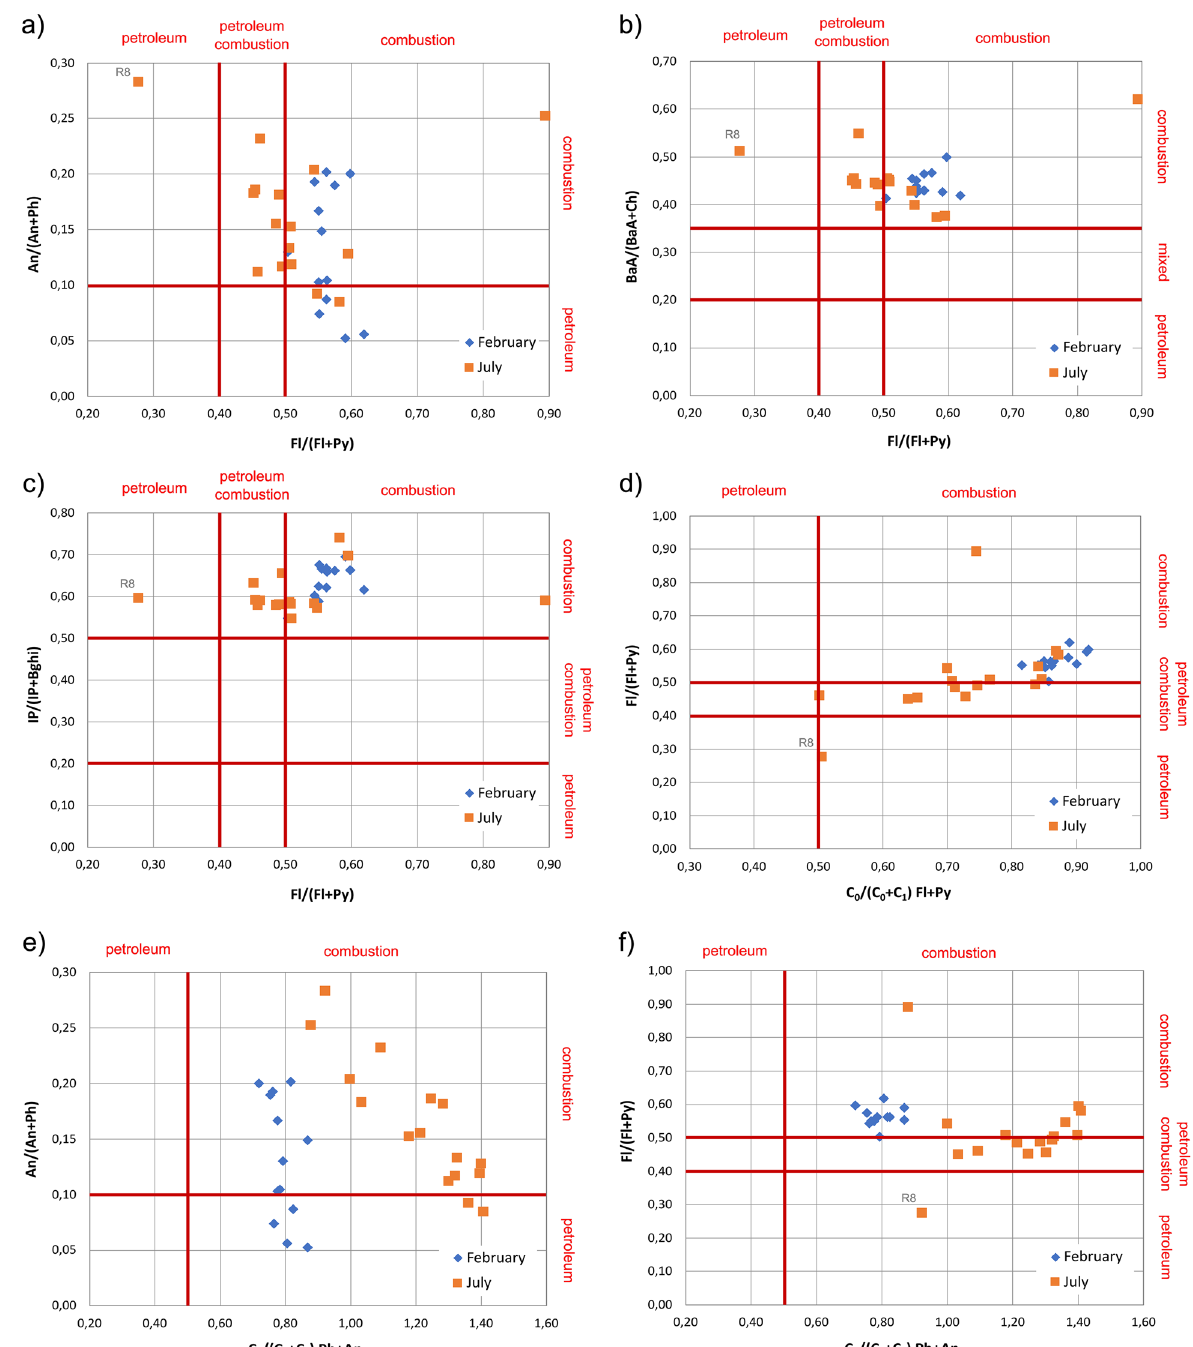
Fig. 4 PAH diagnostic ratios to differentiate and classify emission sources (petrogenic vs pyrogenic). Cross plots of a An/(An b